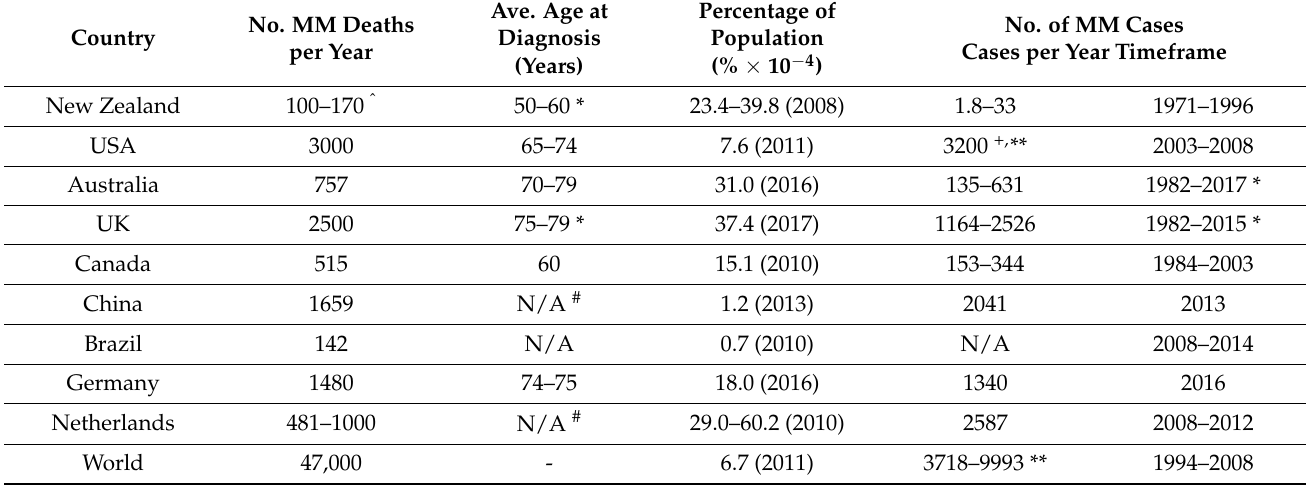
Table 2. Demographics of MM cases